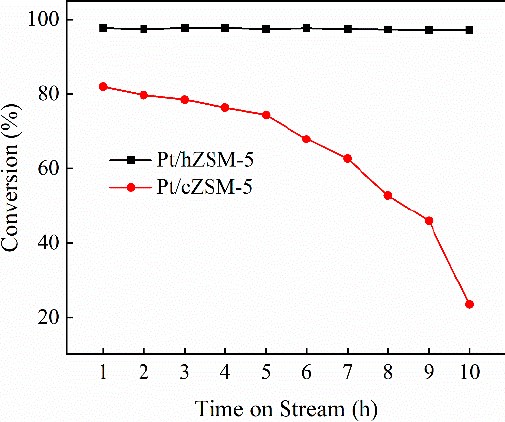
Figure 9. Guaiacol conversion as a function of time on stream over Pt/hZSM-5 and Pt/cZSM-5 catalysts.